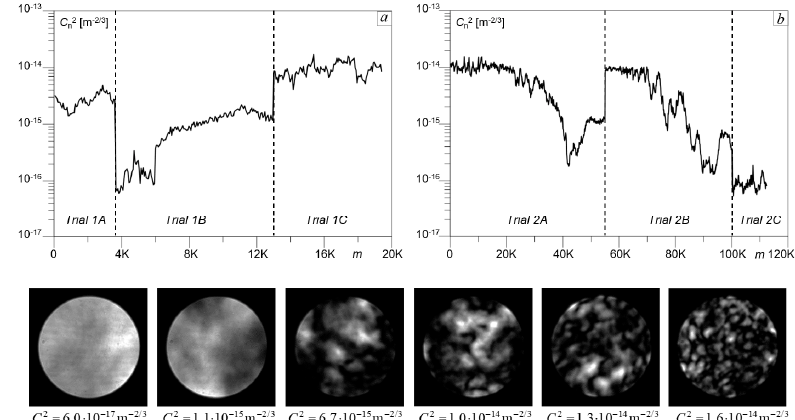
Figure 2. Graphical representation of the refractive index structure parameter C 2 n (logarithmic scale) for the measurement trial 1A, 1B, and 1C (ATM#1 dataset) ( a ) and 2A, 2B, and 2C (ATM#2 dataset) ( b ). Each dataset is comprised of intensity scintillation images and C 2 n values synchronously measured by the BLS-2000 scintillometer during the atmospheric sensing trial. Index m corresponds to image frame number (frame stamp) in each dataset. Grey scale images below represent exemplary (selected from the ATM#1 dataset) scintillation patterns captured under different atmospheric turbulence conditions (different 2 n C values).